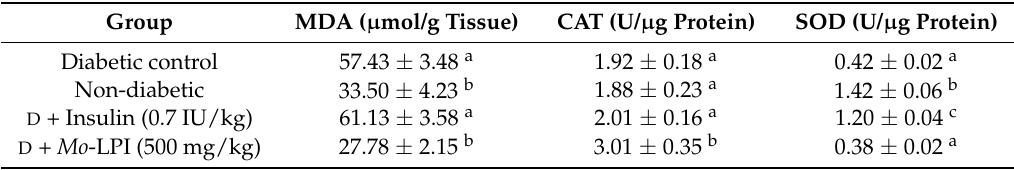
Table 1. Malondialdehyde levels and antioxidant enzyme activities in hepatic tissues of non-diabetic and alloxan-induced diabetic mice. Group MDA ( µ mol/g Tissue) CAT (U/ µ g Protein) SOD (U/ µ g Protein) Diabetic control 57.43 ± 3.48 a 1.92 ± 0.18 a 0.42 ± 0.02 a Non-diabetic 33.50 ± 4.23 b D + Insulin (0.7 IU/kg) 61.13 ± 3.58 a D + Mo -LPI (500 mg/kg) 27.78 ± 2.15 b 0.38 ± 0.02 a Values are means ± S.E.M. ( n = 10). Diabetic control: vehicle (0.05 M Tris-HCl, pH 7.5, containing 0.15 M NaCl); Non-diabetic: vehicle (0.05 M Tris-HCl, pH 7.5, containing 0.15 M NaCl); D + insulin: diabetic mice + rapid-acting human recombinant insulin (0.7 IU/kg · bw, Novorapid ® ); D + Mo -LPI: diabetic mice + Mo -LPI (500 mg/kg · bw). Different letters in the same column indicate significant differences ( p < 0.05) when compared with the